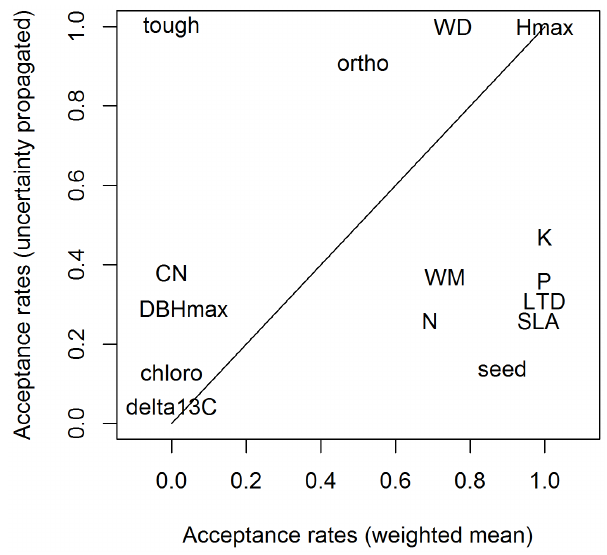
Figure 2. The use of mean traits may produce false signals. Results of the Kuo-Mallick algorithm for parameter selection using weighted means of trait vales are different from what we obtain when we correctly propagate